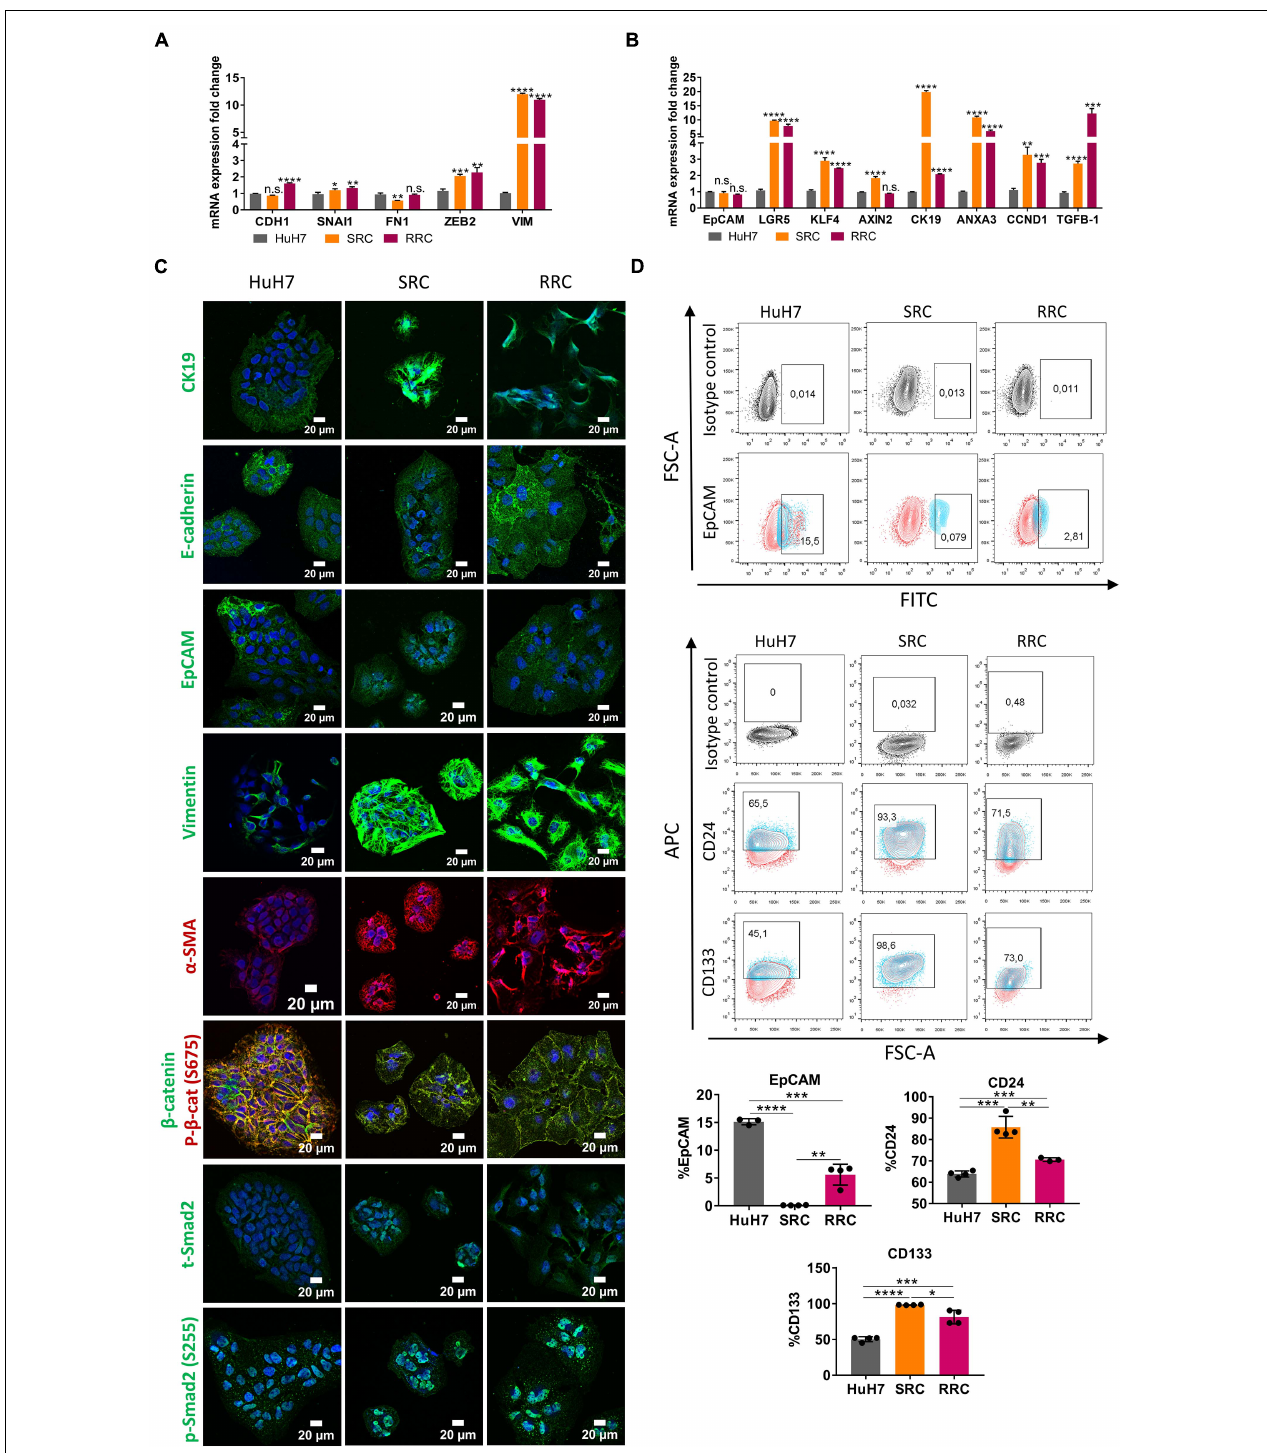
FIGURE 5 | Regorafenib resistant cells have increased mesenchymal gene expression and cancer stem-cell marker expression. (A) Expression of mesenchymal and epithelial genes as well as (B) hepatic stem/progenitor genes were analyzed by q-PCR. Data represent the average of at least three independent experiments. p > 0.05 (n.s.), p ≤ 0.05 (*), p ≤ 0.01 (**), p ≤ 0.001 (***), p ≤ 0.0001 (****). Error bars indicate standard deviation (SD). (C) Expressions of CK19, E-CAD, EpCAM, VIM, a-SMA, SMAD2 and β -catenin were analyzed in parental and resistant cell lines by immunofluorescence. Images were acquired on a Carl Zeiss LSM 880 AxioObserver confocal microscope with a C-Apochromat 40x/1.2 W, Korr FCS M27 objective. (D) Cancer-stem cell marker (EpCAM, CD24 and CD133) positive cell populations were analyzed via BD LSR Fortessa flow cytometer in sorafenib resistant (SRC) and regorafenib resistant (RRC) cells.